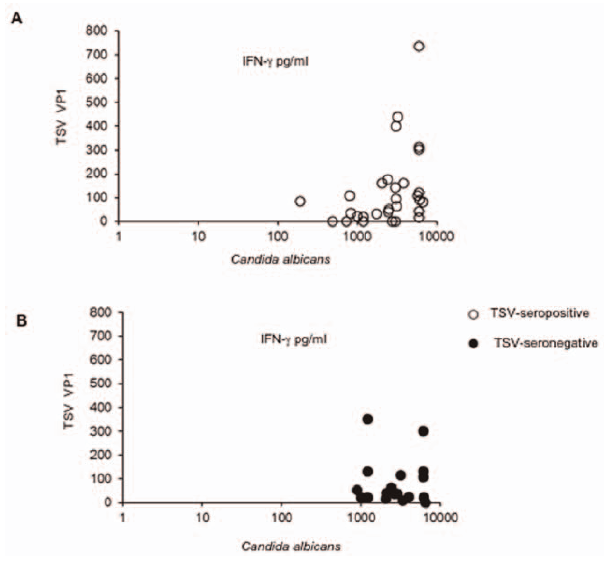
Figure 2. Correlation between TSV VP1 and Candidaalbicans- specific IFN- c responses. Correlation analysis between TSV VP1 and Candida albicans- specific IFN- c responses were analysed among TSV- seropositive (A) and seronegative (B) individuals. doi:10.1371/journal.pone.0045773.g002 healthy controls (5d response higher than 3d response); with TSV-